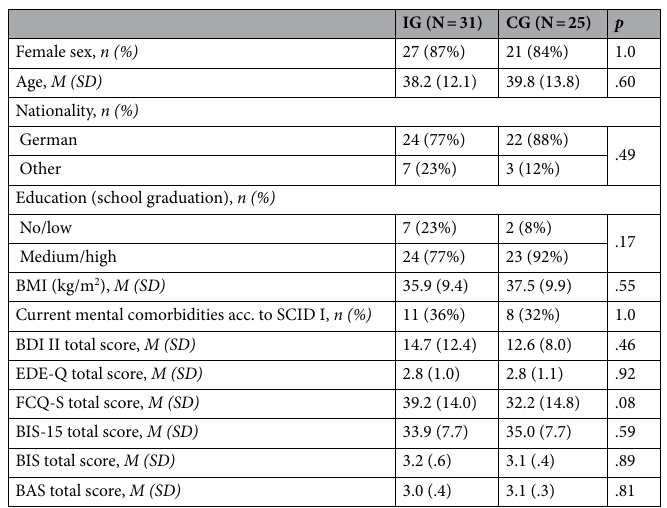
Table 1. Sample characteristics of the IMPULS group (IG) and the control group (CG) at baseline (T0). BAS Behavioral Activation System, BIS Behavioral Inhibition System, BIS-15 Barratt Impulsiveness Scale (short version), BDI II Beck Depression Inventory (second version), EDE-Q Eating Disorder Examination Questionnaire, FCQ-S Food Craving Questionnaire State, SCID I Structured Clinical Interview for DSM-IV Disorders, Axis I.